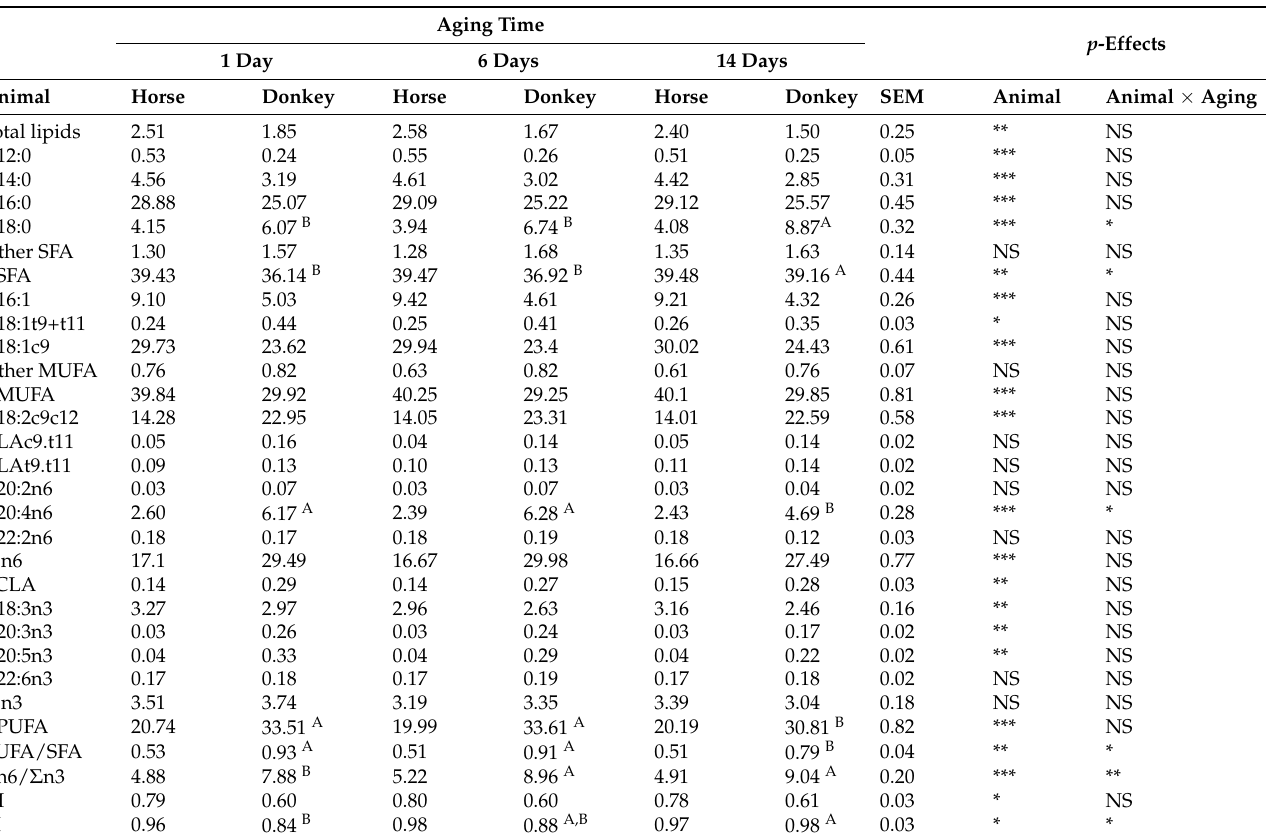
Table 3. Total lipids and fatty acid profile (g/100 g fatty acids) of horse and donkey meat during aging time (means ± SEM).